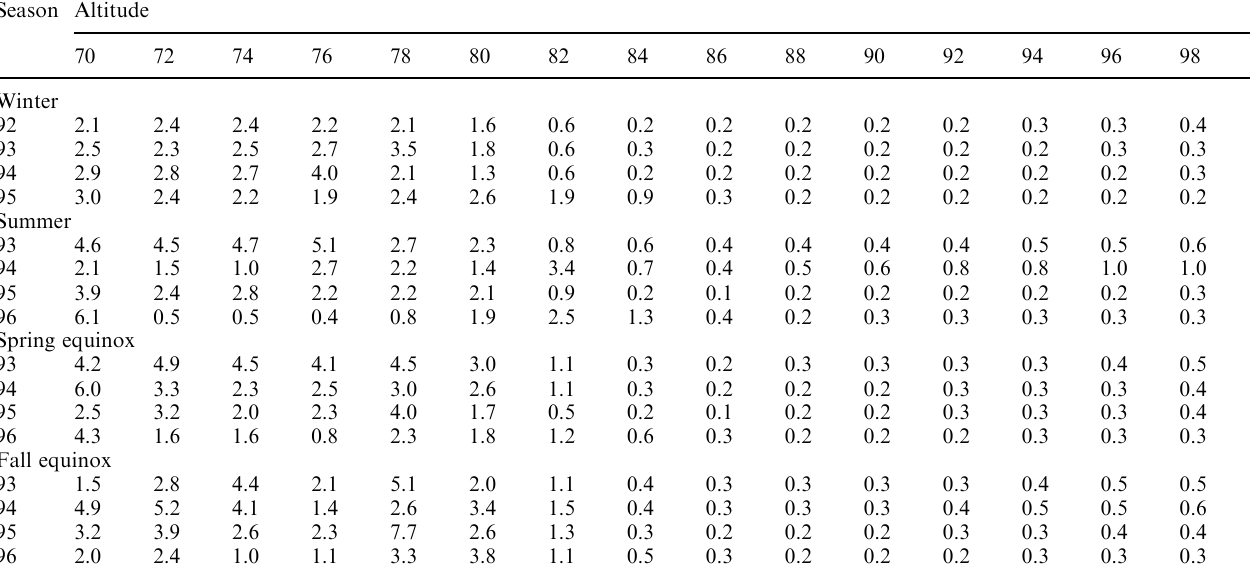
Table 2. Overall standard error for meridional wind Season Altitude